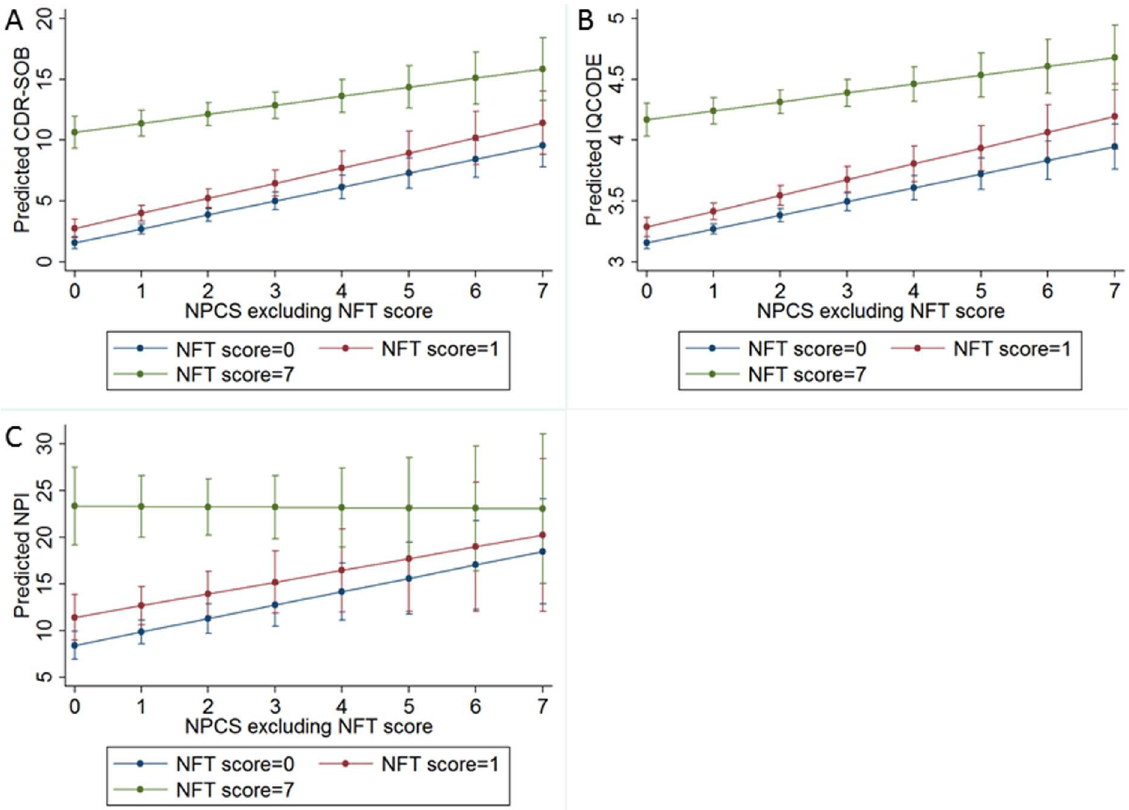
Fig 3. Predicted values of (A) the CDR Sum of Boxes (CDR-SOB), (B) the Informant Questionnaire on Cognitive Decline in the Elderly (IQCODE), and (C) the Neuropsychiatric Inventory (NPI) considering the Neuropathological Comorbidity Score (NPCS) without Alzheimer disease pathology for participants with Neurofibrillary Tangle (NFT) score = 0 (BraakNFT stage = 0–II: Blue line), NFT score = 1 (BraakNFT stage = III–IV: Red line), and NFT score = 7 (BraakNFT stage = V–VI: Green line). Predicted values of cognitive and neuropsychiatric outcomes were obtainedby multivariate linear models adjustedfor age, sex, and education.